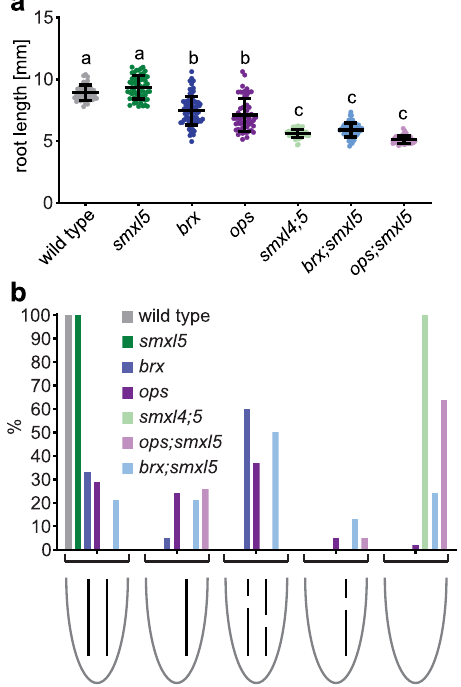
Fig. 3 | Genetic interaction of SMXL5 with OPS and BRX . a Root length of 5-day- old wild-type (WT), smxl5 , brx , ops , smxl4;smxl5 , brx;smxl5 , and ops;smxl5 plants. n between 38 (for ops;smxl5 ) and 76 (for brx ), see Source Data File for exact sample sizes of all groups. Statistical groups determined by one-way ANOVA and post hoc Tukey ’ s HSD test (95% CI). Shown is one representative experiment of three repe- titions. b Phenotypic characterization of phloem development of 2-day-old wild- type, smxl5 , brx , ops , smxl4;smxl5 , brx;smxl5 ,and ops;smxl5 plants. n between18(for s mxl5 and brx )and49(for brx;smxl5 ),seeSourceDataFileforexactsamplesizesof all